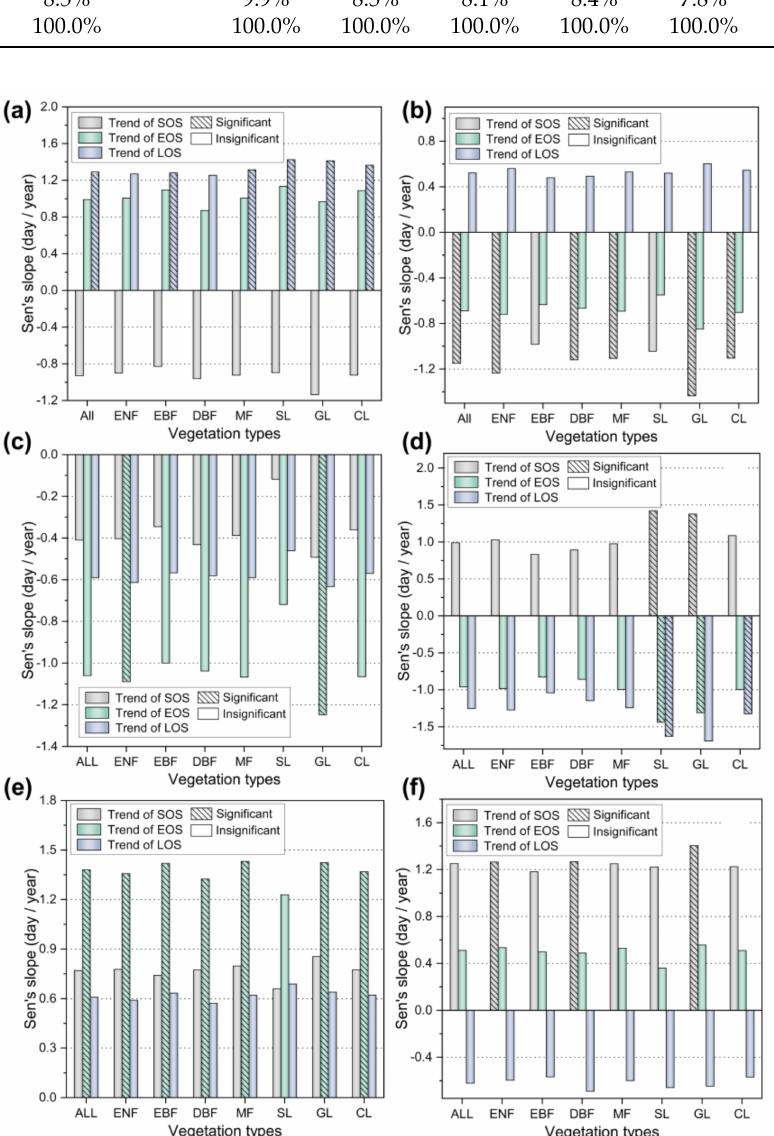
Figure 7. Trends and significance of each pattern during the growing season for different vegetation types. ( a ) growing season pattern I. ( b ) growing season pattern II. ( c ) growing season pattern III. ( d ) growing season pattern IV. ( e ) growing season pattern V. ( f ) growing season pattern VI. Note: “All” refers to all vegetation in the